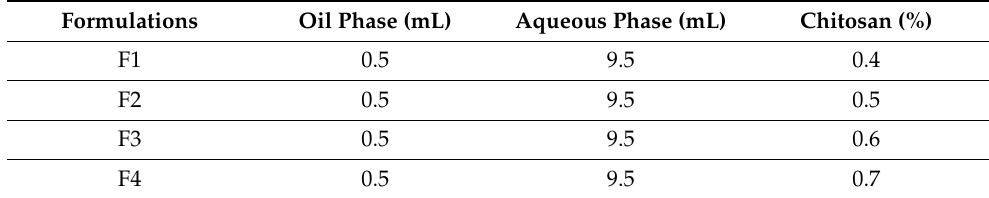
Table 3. Composition of the formulations for the hypericin nanoemulsion. Formulations Oil Phase (mL) Aqueous Phase (mL) Chitosan